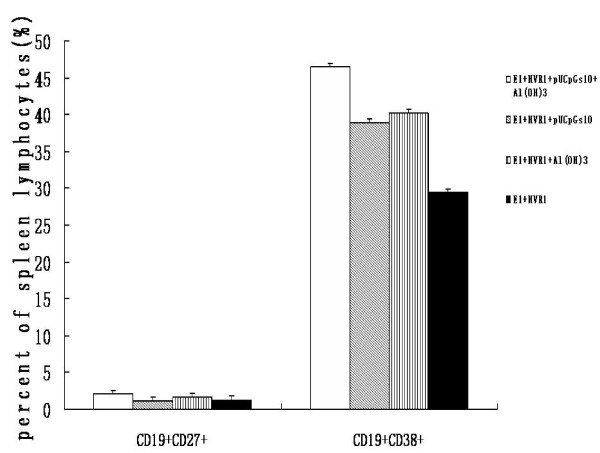
The result of ELISPOT, FCM and ELISA of the spleen lymphocyte in BALB/c mice (mean ± SD). The application of aluminium have statistical significance of the population of the CD19+CD27+ B cell and CD27+CD38+cell. (P < 0.01, P < 0.0001). The population of the CD19+CD38+ B cell of Alum+CpG to the PBS group have statistical significance.(P < 0.05). The concentration of IL-6, IL-10 in cultivated supernatant of the splenic lymphocytes of the BALB/c mice after the incentivation of HCV antigen in vitro(mean ± SD)The concentration of IL-6 and IL-10 was determined by ELISA from the four groups of four mice and single-cell suspensions were prepared. After lysing red blood cells with Tris-NH4Cl, splenocytes (5 × 106 cells in 200 ml) were cultured at 37°C withE1+HVR1 recombination antigen (20 μg/ml)or LPS(1 μg/ml)in vitro, using the ELISA assay to measure the titer of IL-6 and IL-10. Results are shown as the mean value obtained for duplicate wells.